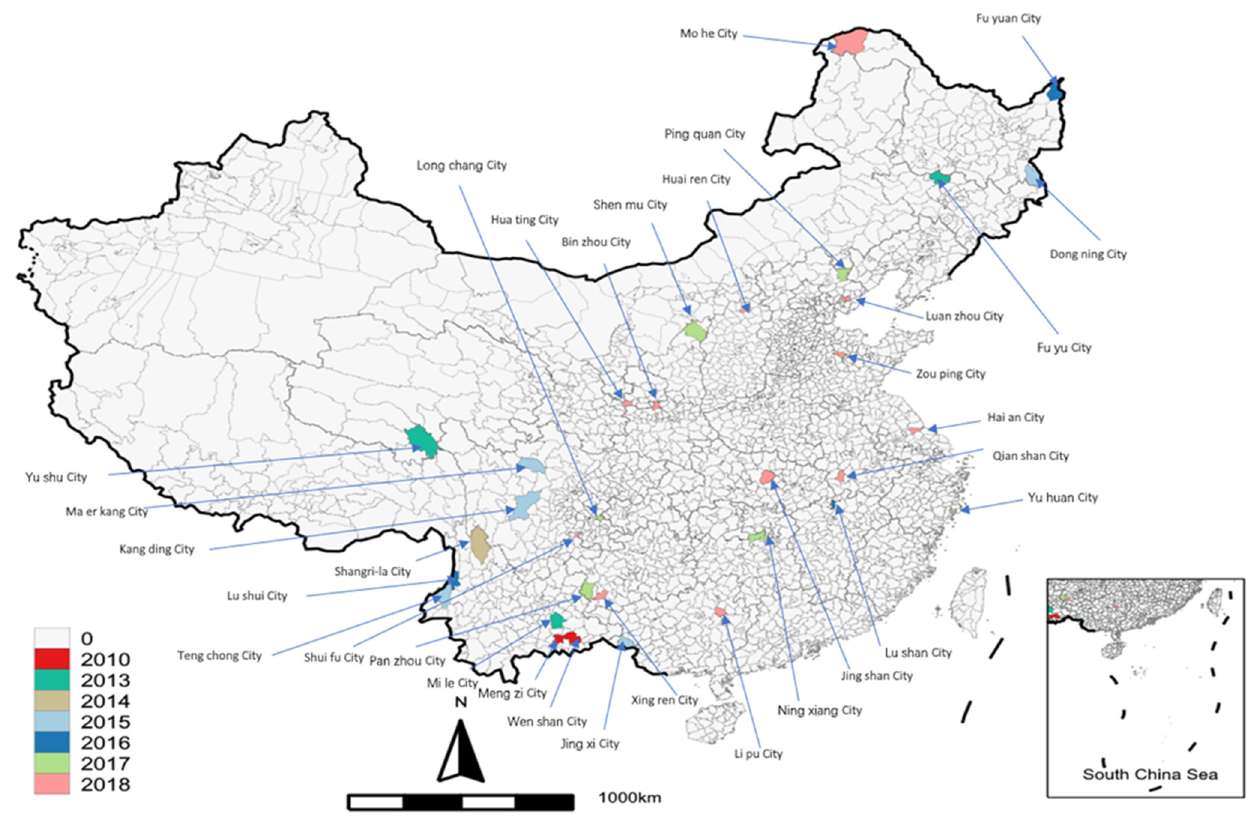
Figure 2. The location of new cities during 2005–2018. Data source: the website of the Ministry of Civil Affairs.